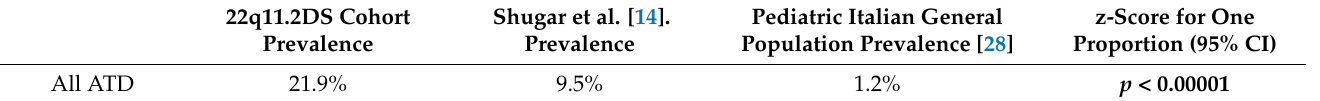
Table 5. ATD prevalence in our 22q11DS cohort and literature and in Italian general